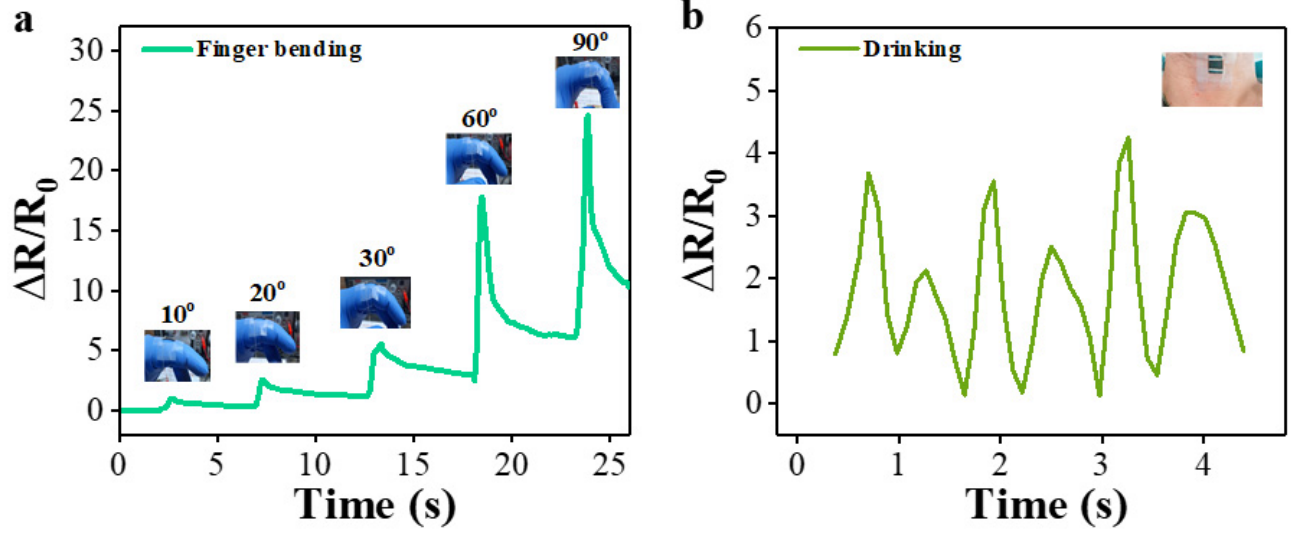
Figure 10. Applications of multi-layer PPy/PDMS strain sensors in monitoring the human body motions. Normalized resistance signals measured from ( a ) the finger’s bending of different degrees (10–90°) to recovery and ( b ) the motion of drinking water.